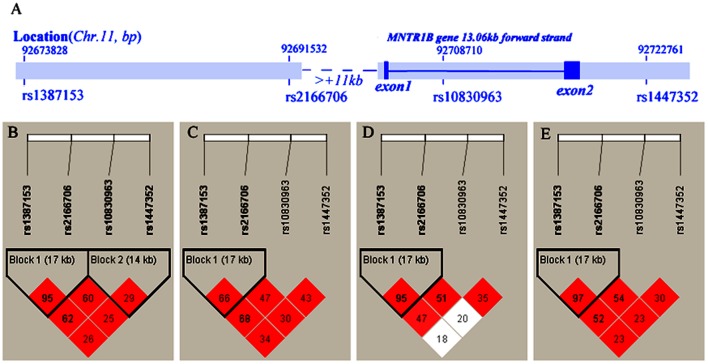
The MTNR1B gene structure and Haploview plot for 4 MTNR1B variants.The MTNR1B gene structure with the location of the variants studied (A) and pairwise D′ Haploview plot for the 4 MTNR1B variants was shown; R-squared was also displayed for LD values. B. based on our data for glucose tolerance status in pregnant Chinese women. C. Europeans. D. Han Chinese in Beijing. E. Chinese in Metropolitan Denver. 88×68 mm (600×600DPI).